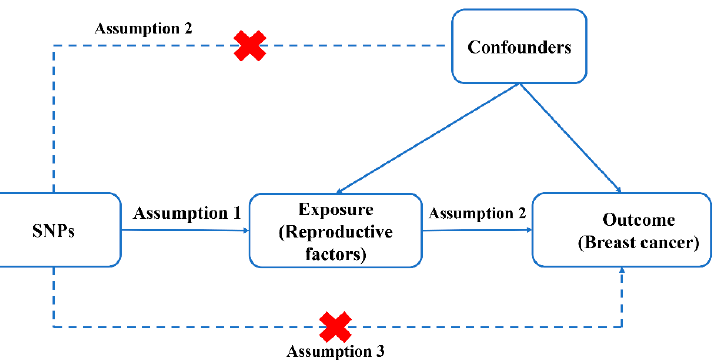
Figure 1. Diagram for Mendelian randomization (MR). MR is based on three hypotheses. First, SNPs selected as IVs should be closely related with exposure; second, selected SNPs must be independent of confounders; third, IVs are associated with BC (outcome) only via reproductive factors (exposure) rather than through a direct